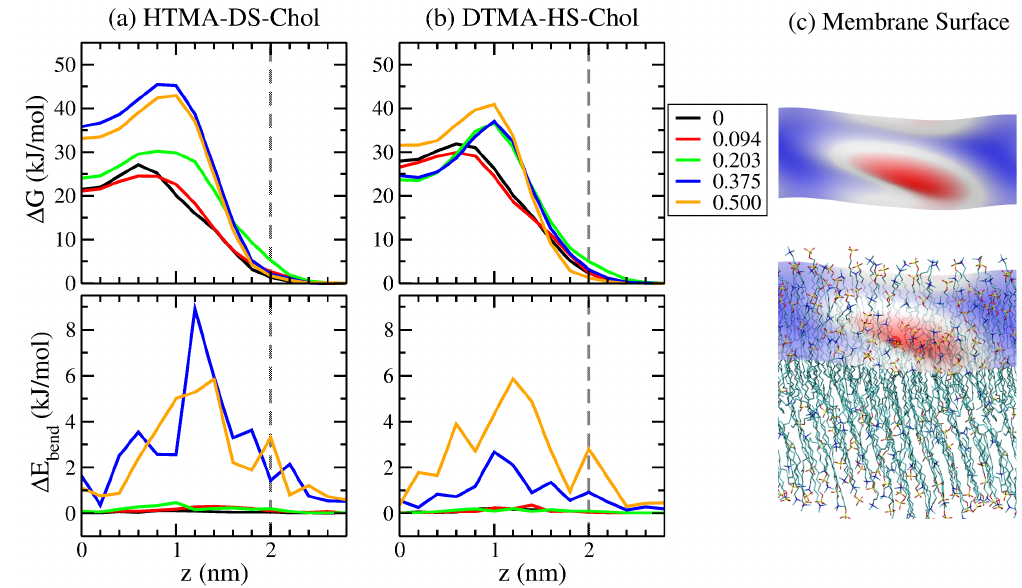
Figure 5. The free energy profiles (top panels) and the membrane bending energy profiles during water permeation for ( a ) HTMA-DS-Chol and ( b ) DTMA-HS-Chol bilayers at various X chol . In addition ( c ) the representative membrane surface with maximum bending energy at z = 1.2 nm, and the superimposition of the surface with the bilayer structure where the permeant water oxygen is labeled with red sphere. Graphics were generated using VMD package